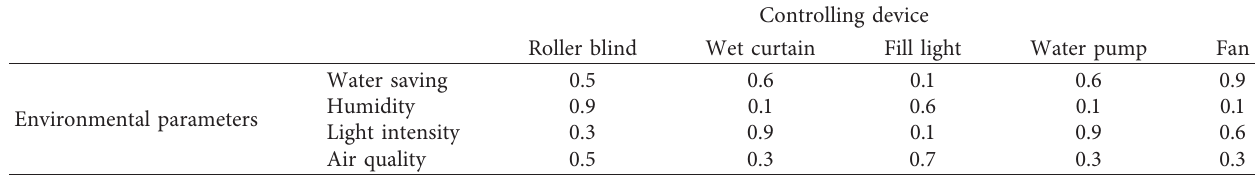
Table 2: Green building subindices and key application stages.